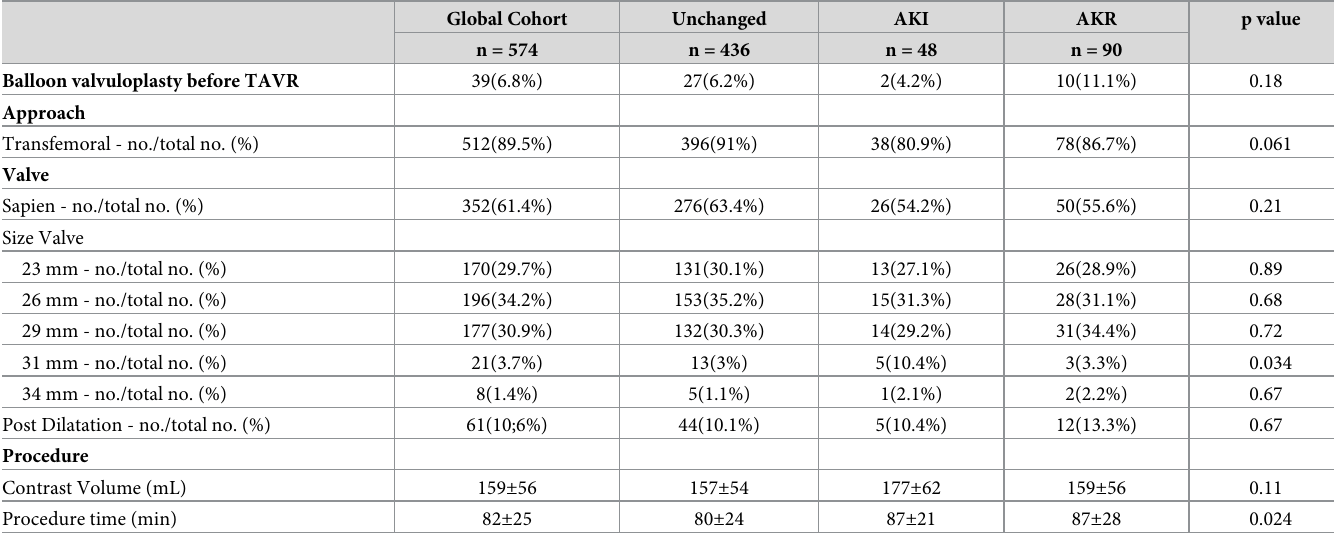
Table 2. Procedural